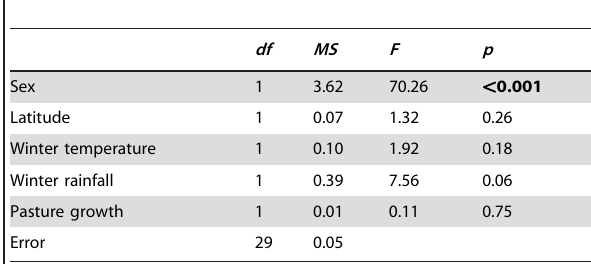
Table 1. An absence of geographic variation in body